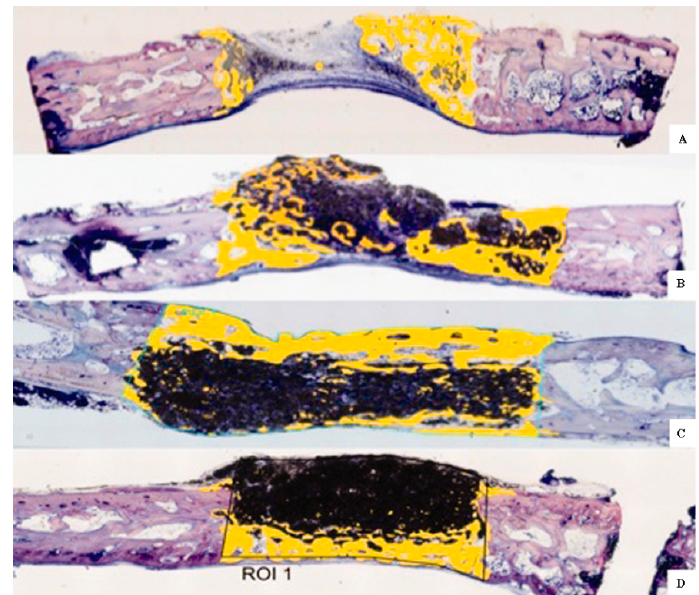
Figure 1. Histological cross-sections after 60 days of implantation for each of the three HA/ β -TCP/collagen scaffolds: control ( A ), 40/30/30 scaffolds ( B ), 50/20/30 scaffolds ( C ), 60/20/20 scaffolds ( D ). Black: residual scaffold. Yellow: bone remodeling site (resorption foci). Reprinted from [25] with permission from Wiley.